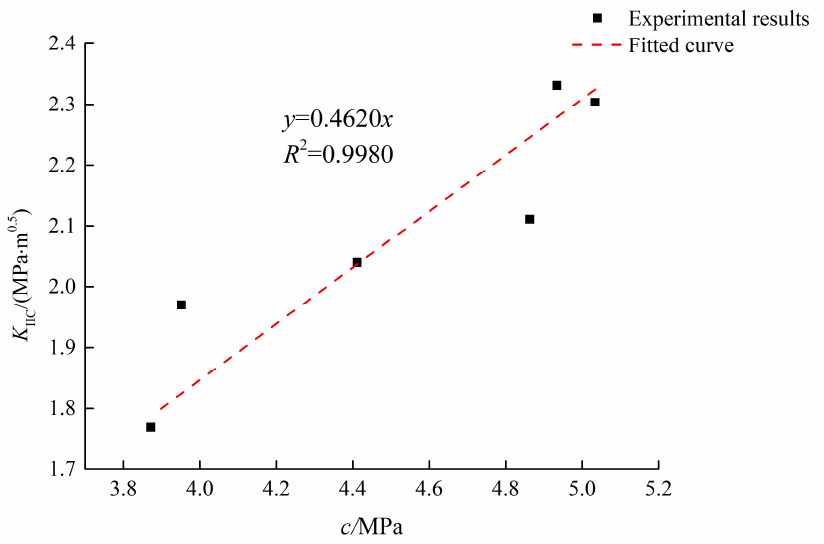
Figure 4. Linear relation of K ΙΙ C and c (modified from [49]).